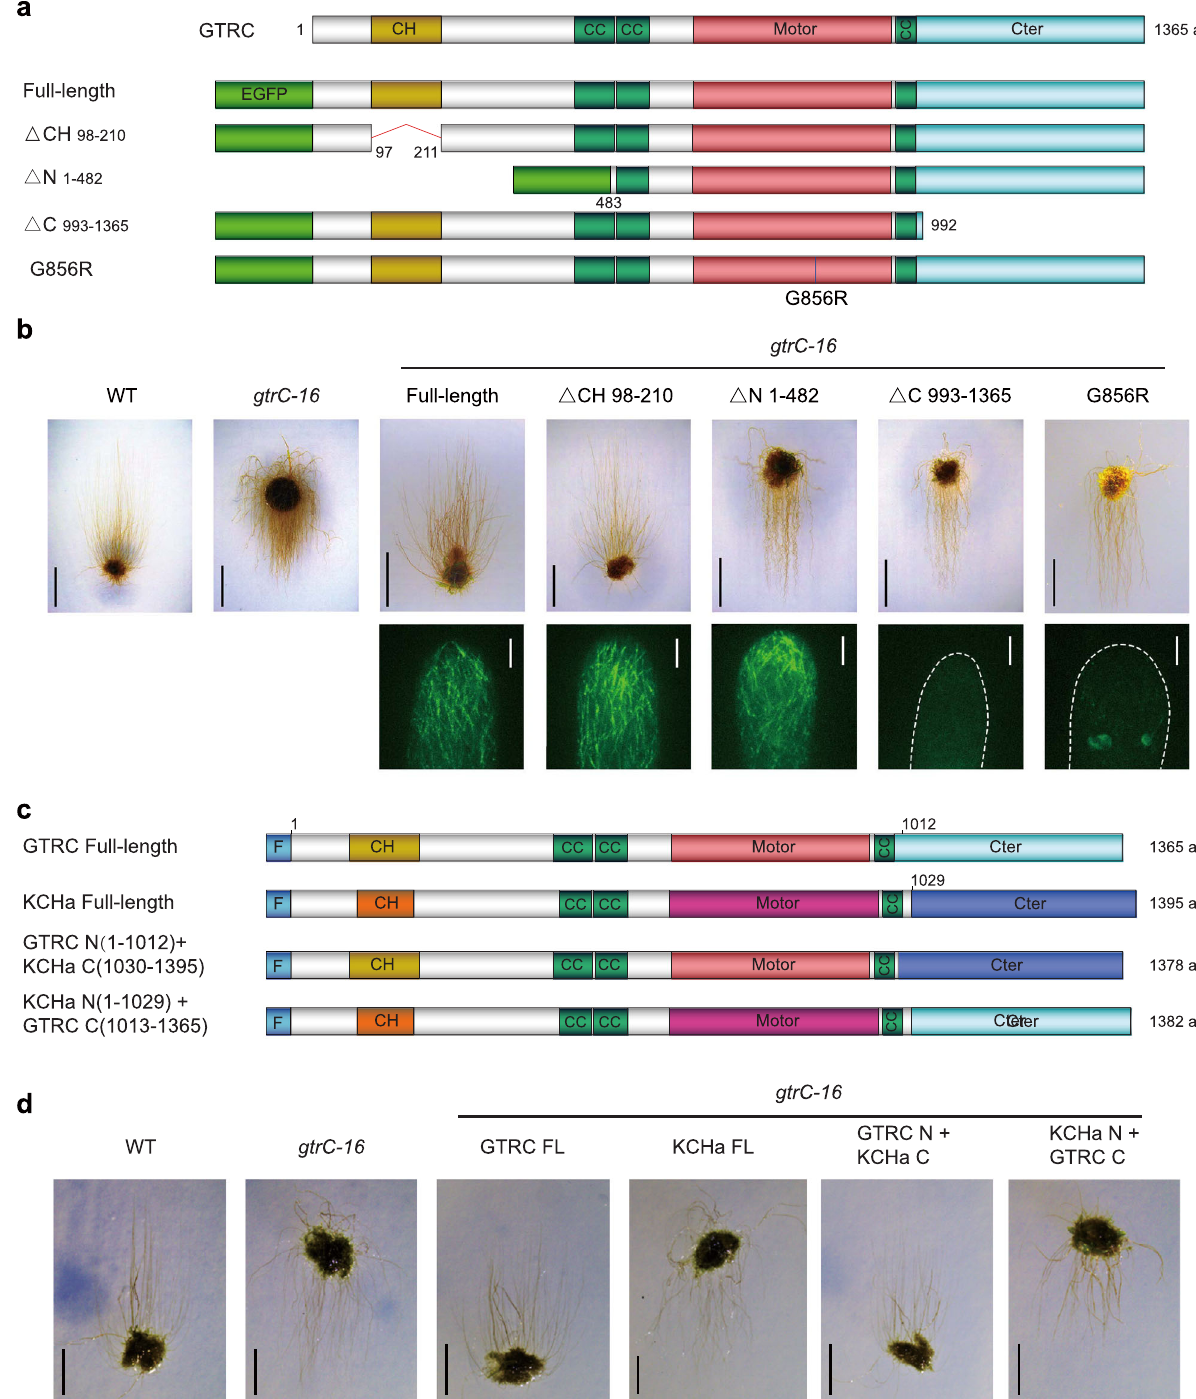
Fig. 5 Functional domain analysis of GTRC protein. a Schematic diagrams of full length and truncated constructs of GTRC . GFP was fused to the N- terminus of each fragment. b Complementation and fl uorescence analyses of truncated GTRC. Upper, various constructs of GTRC were used to replace the genomic GTRC in gtrC-16 via homologous recombination, and then the protonemata were grown on vertical plates. Scale bars, 3 mm. Lower, subcellular localization of GFP-fused full length or truncated GTRC proteins. Scale bars, 5 μ m. White dashed lines depict the contours of the tip cells. For each genotype, the fl uorescence of more than 10 tip cells was collected, and the results were similar. c Schematic diagrams of full length and chimeric constructs of GTRC and KCHa . 3×FLAG (F) was fused to the N-terminus of each fragment. d Functional analyses of chimeric proteins between GTRC and KCHa. Various constructs were used to replace the genomic GTRC in gtrC-16 via homologous recombination, and then the protonemata were grown on vertical plates. Scale bars, 2 mm. The details of the constructs and genotypes for the P. patens lines are shown in Supplementary Fig.